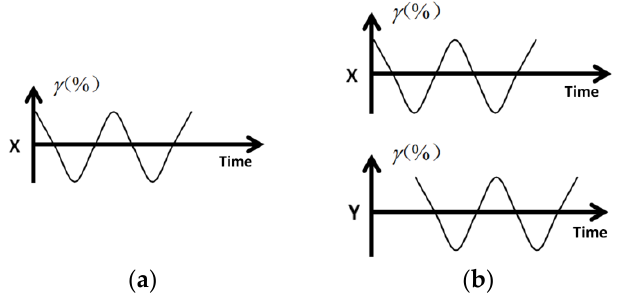
Figure 4. Waves of ( a ) uni ‐ directional shear loadings and ( b ) multidirectional shear ‐ circular loading (Reprinted from [29]).